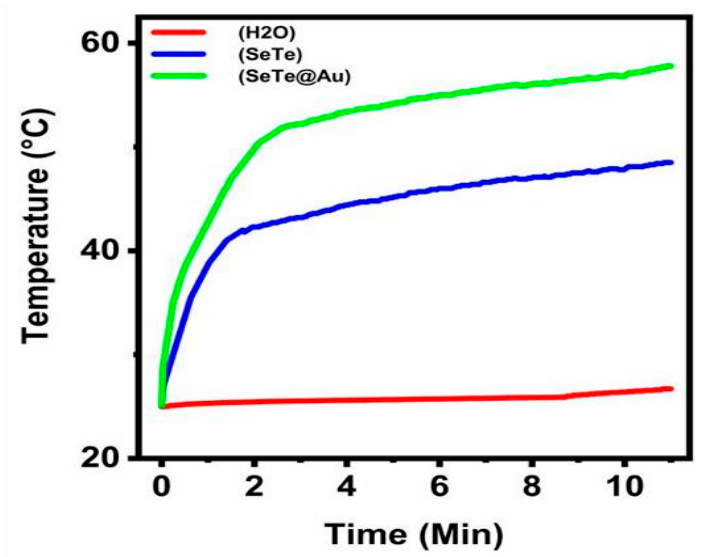
Figure 8. Temperature change measurement of Se-Te and SeTe@Au at a power of 1.00 W cm − 2 .